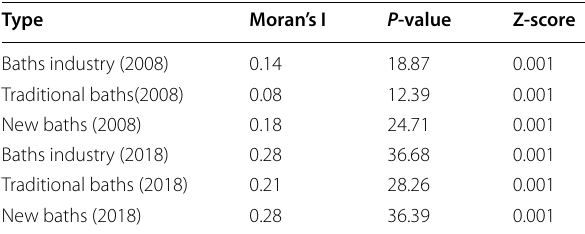
Table 2 Global Moran’s I statistics for bath industry and its sub-